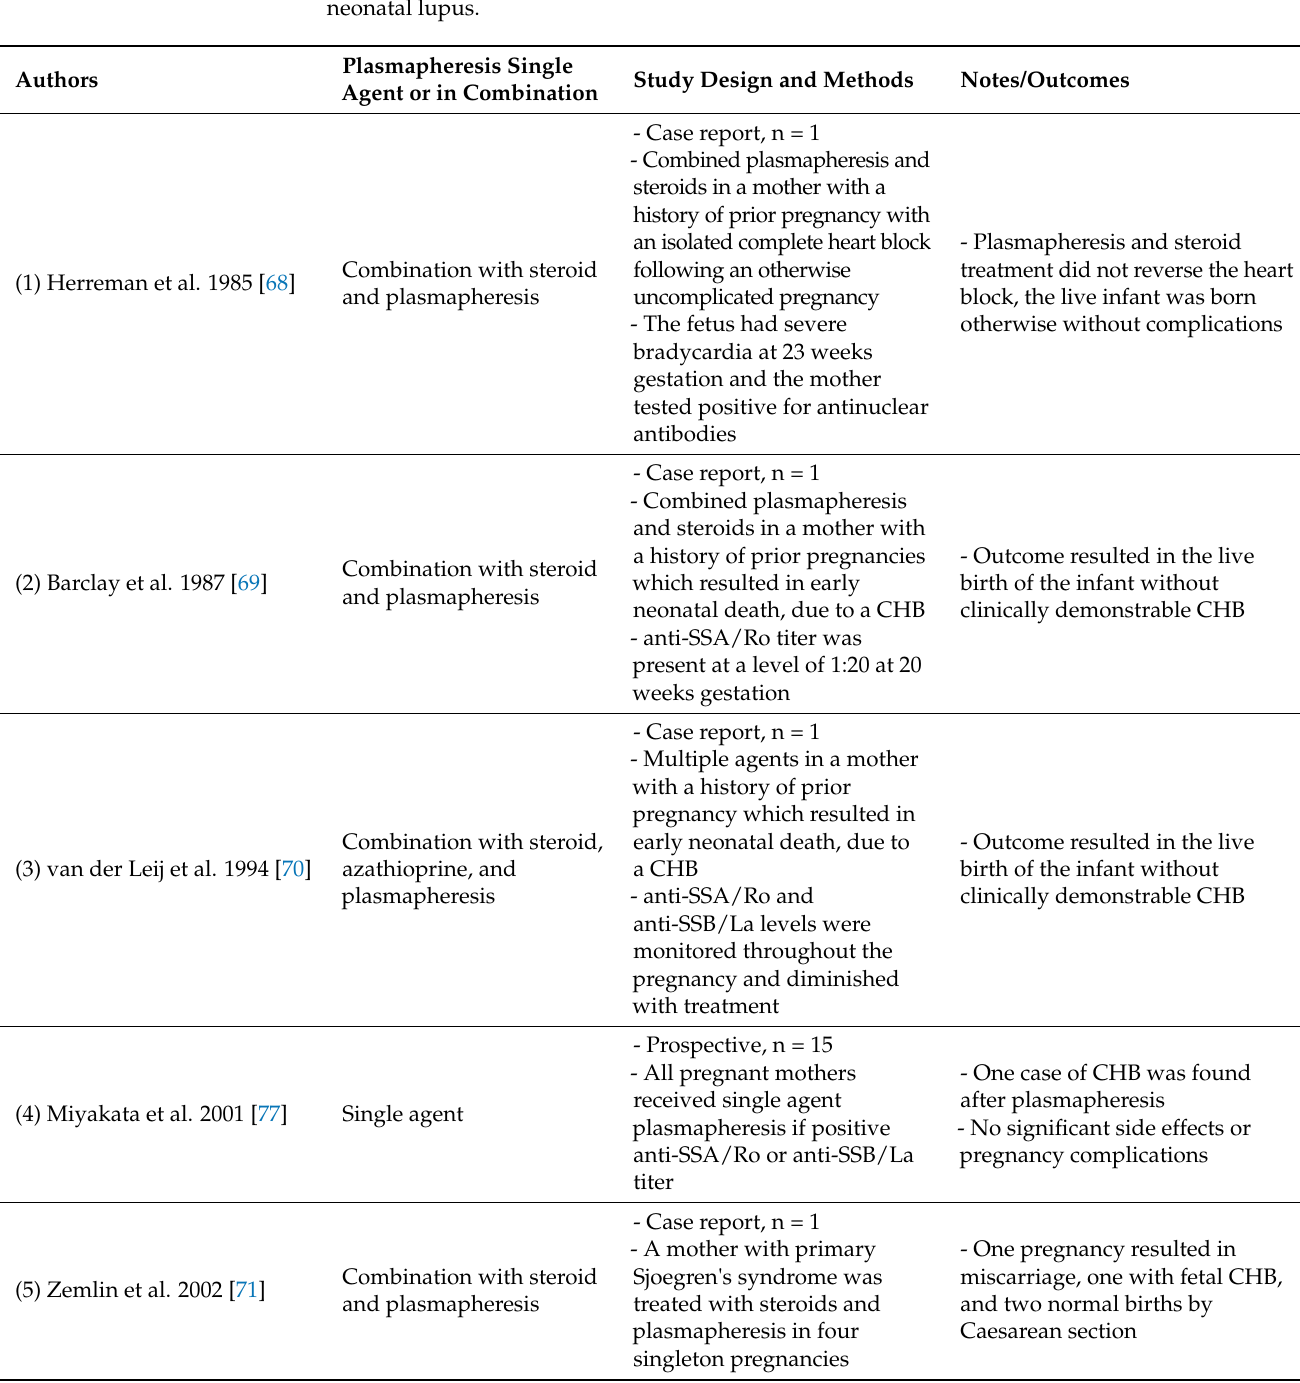
Table 1. Summary of studies describing plasmapheresis in pregnant mothers with cardiac neonatal